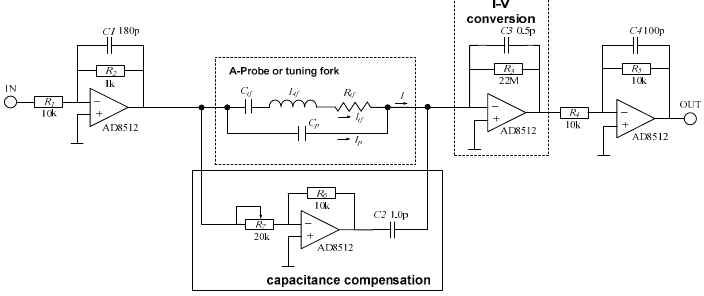
Figure 6. Typical circuit diagram for an Akiyama probe amplification